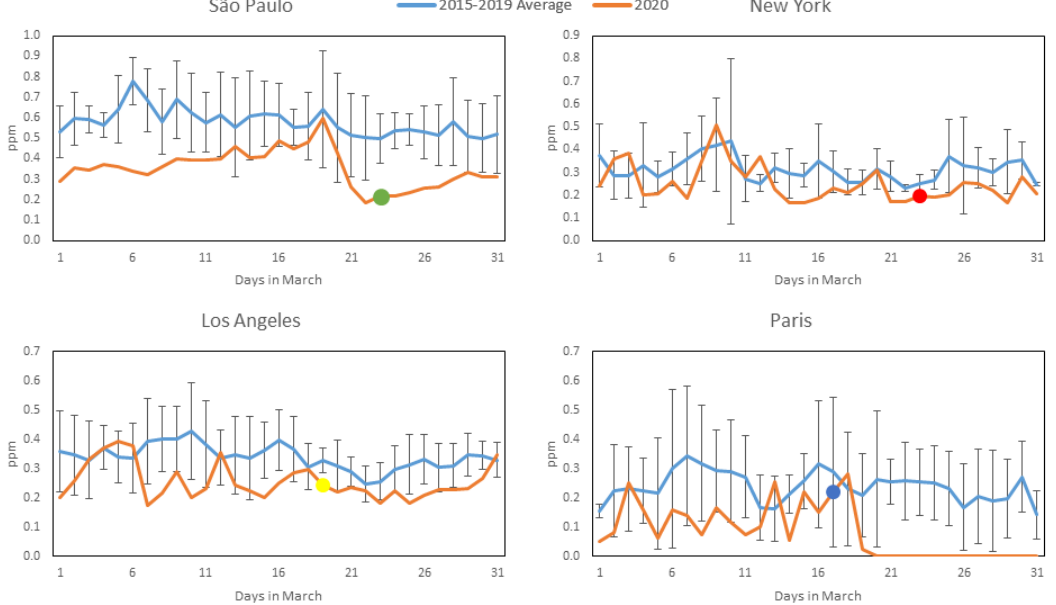
Figure 2. CO concentration profiles during March 2020 (Orange) compared to average and standard deviation of March concentrations over the previous 5 years (Blue) for the four studied cities (most significant COVID-19 intervention date indicated with colored dot). All available station data used for each city (see Section 2.2).